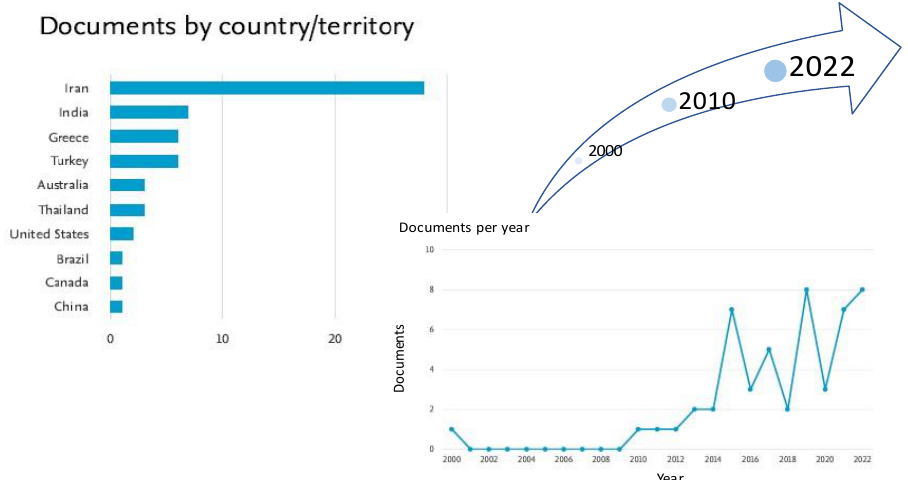
Figure 2. Graphical representation of the increasing number of publications per country since 2000 using as keywords saffron and encapsulation in the title, abstract, or keyword fields (51 documents of all types, Scopus search carried out in January 2023).